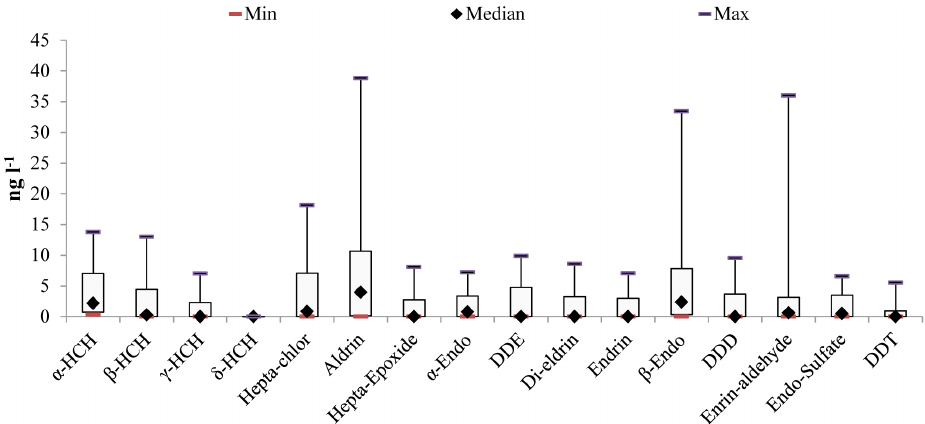
Figure 7. Organochlorine residues (ng l −1 ) in water matrices of rivers of Bihar (BR) Area